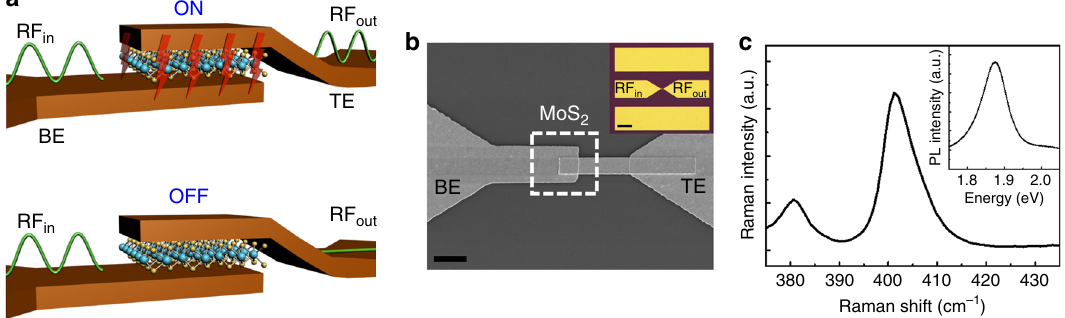
Fig. 1 Device schematics and images with material characterization. a Simpli fi ed illustration of the signal transmission and device structure of the RF switches based on monolayer MoS 2 . b Zoomed-in plan view SEM image of a MoS 2 RF switch with lateral area of 1 × 1 μ m 2 . Scale bar, 2 μ m. The dashed box in b marks the area covered with MoS 2 . The inset is a top-view optical image of a fabricated MoS 2 RF switch with Au electrodes. Scale bar, 50 μ m. c Raman and photoluminescence (inset) spectra of CVD-grown monolayer MoS